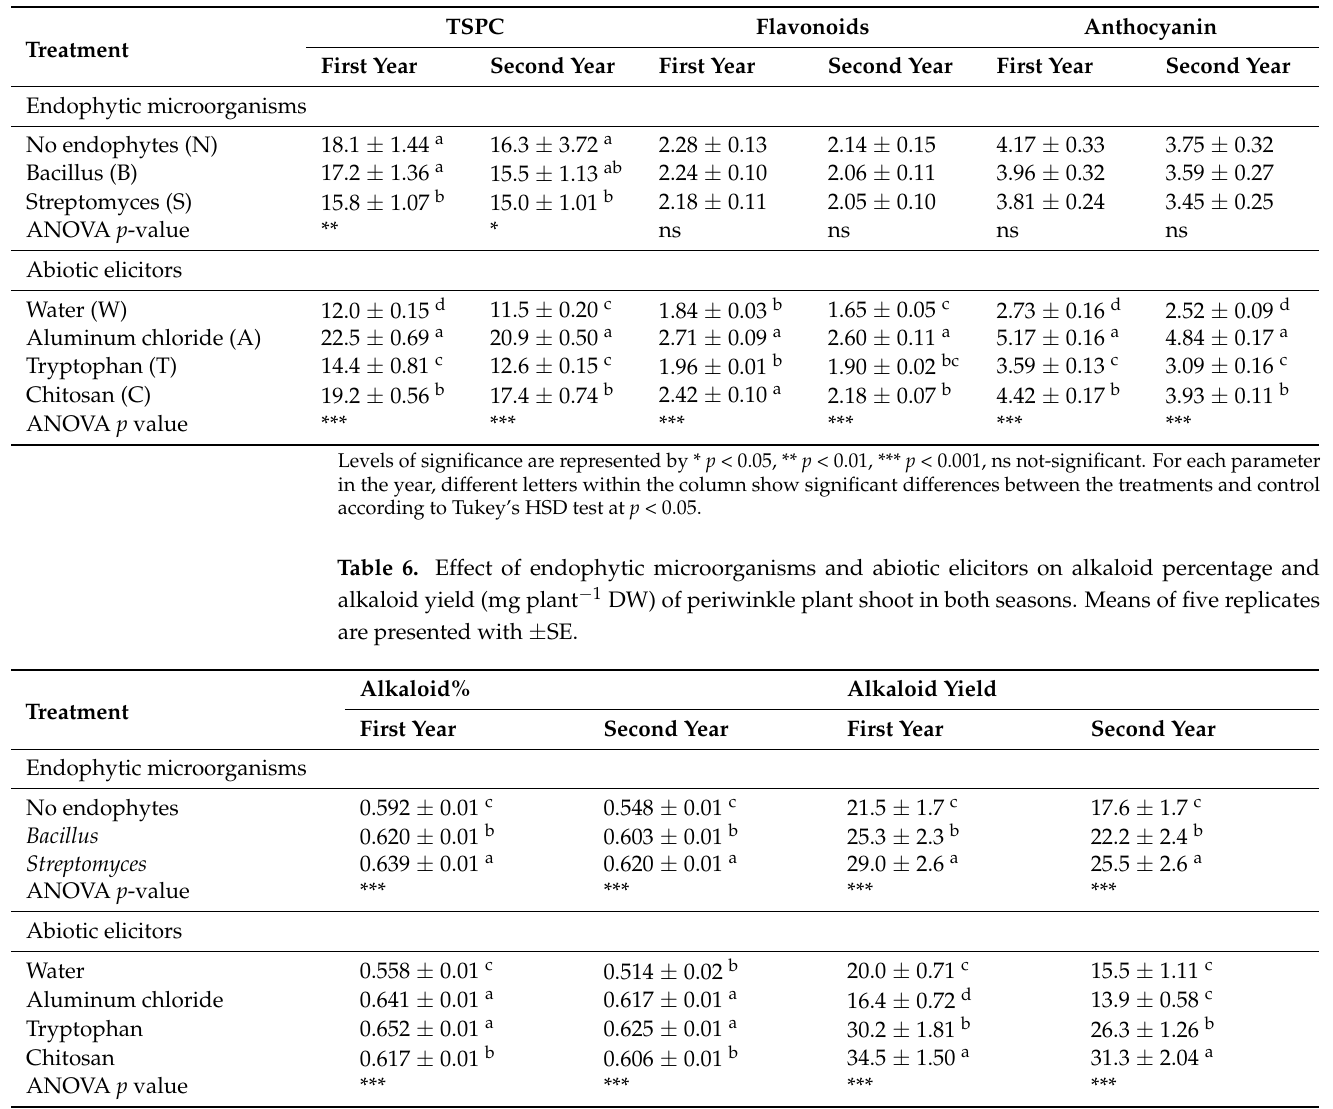
Table 5. Effect of endophytic microorganisms and abiotic elicitors on total soluble phenolic com- pounds (TSPC, mg gallic g − 1 DW); flavonoids (mg quercetin g − 1 DW), anthocyanin (mg 100 g − 1 FW) of periwinkle plant shoot in both seasons. Means of five replicates are presented with ± SE.